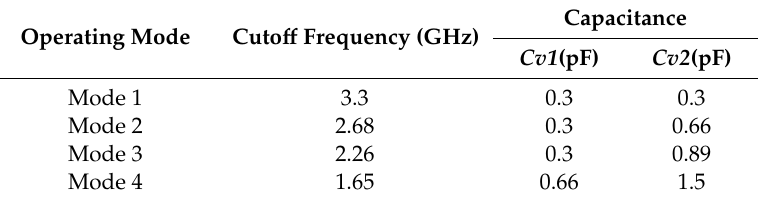
Table 3. Tunable capacitance for di ff erent operating modes.